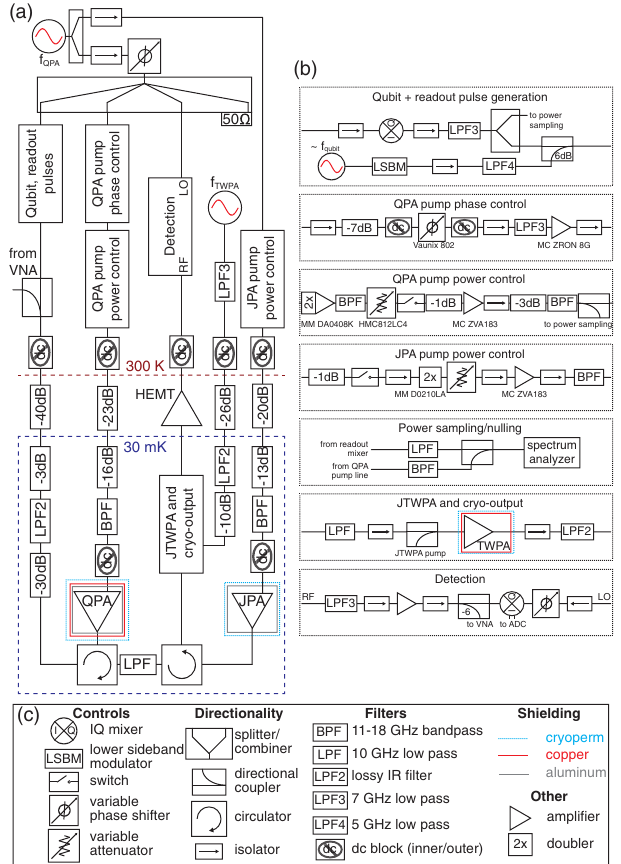
FIG. 5. Detailed experimental wiring